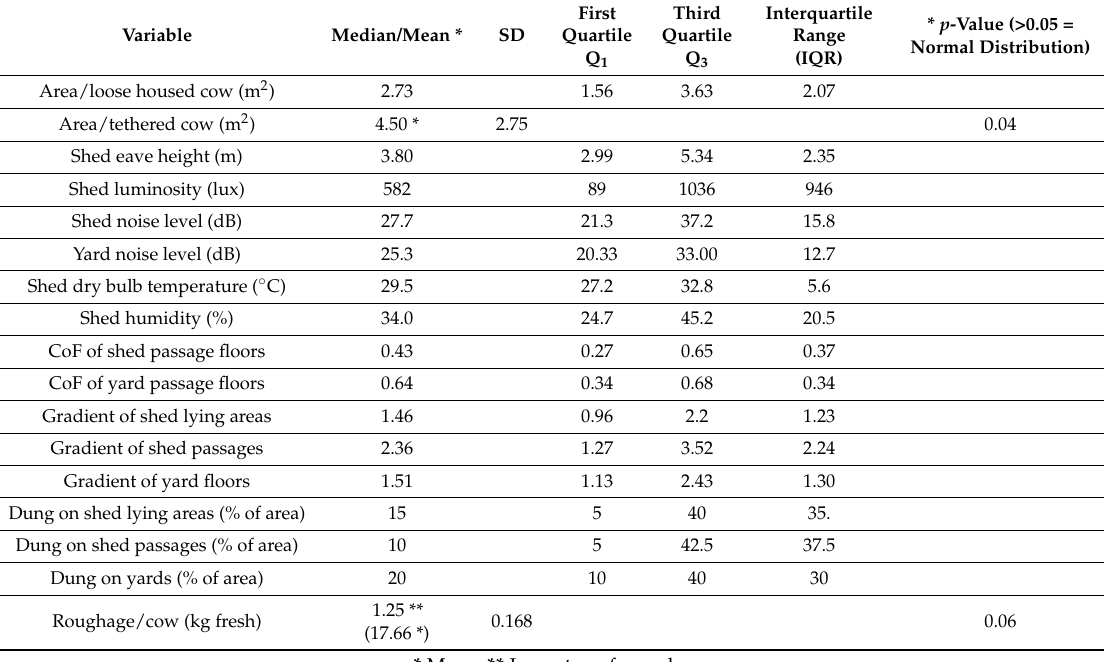
Table 5. Median, first quartile (Q 1 ), third quartile (Q 3 ), and interquartile range (IQR) values for not normally distributed and mean, standard deviation (SD), and p -values for normally distributed data, for resource-based parameters for cows in shelters.